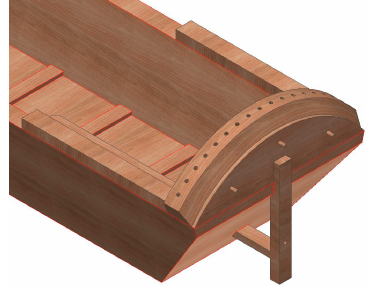
Figure 5 . Detailed view of the transom.